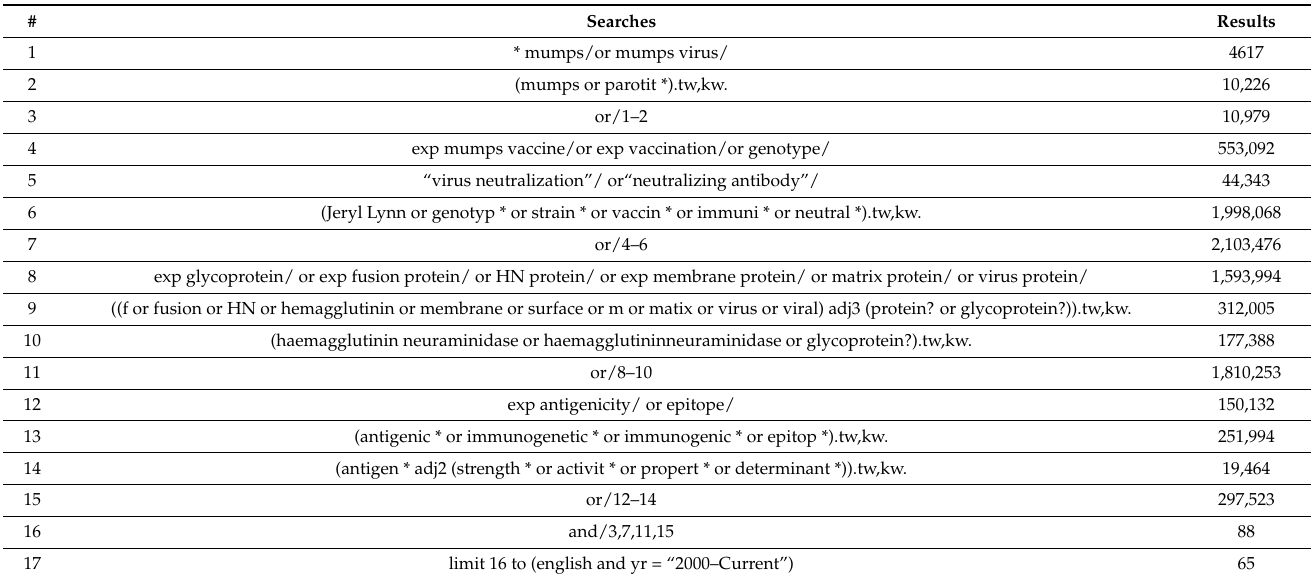
Table 1. Search terms and results for the literature search of mumps